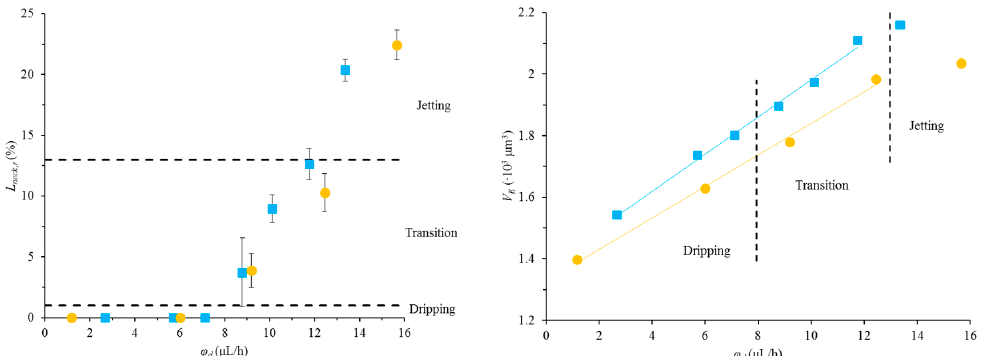
Figure 9. Left: the relative neck length ( Lneck,r ) in the second-to-last-frame-before-detachment of droplets formed in water at flow rates of 75.7 ± 1.5 µL/h ( ■ ) and 92.2 ± 1.5 µL/h ( ● ). The error bars indicate the standard deviation. Right: the experimentally determined droplet volume ( VE ) at a water flow rate of 75.7 ± 1.5 µL/h ( ■ ) and 92.2 ± 1.5 µL/h ( ● ) as a function of the dispersed phase flow rate ( φ d ) with linear fits (both graphs are reproduced from [73]). Reprinted with permission from Elsevier.